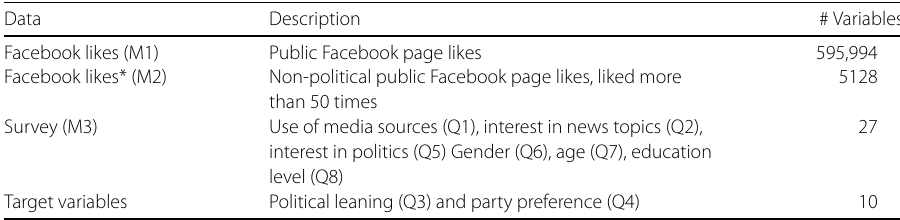
Table 2 Overview of the modeling set-ups with a description of the different datasets and the number of variables. In the description we refer to the survey questions in Appendix